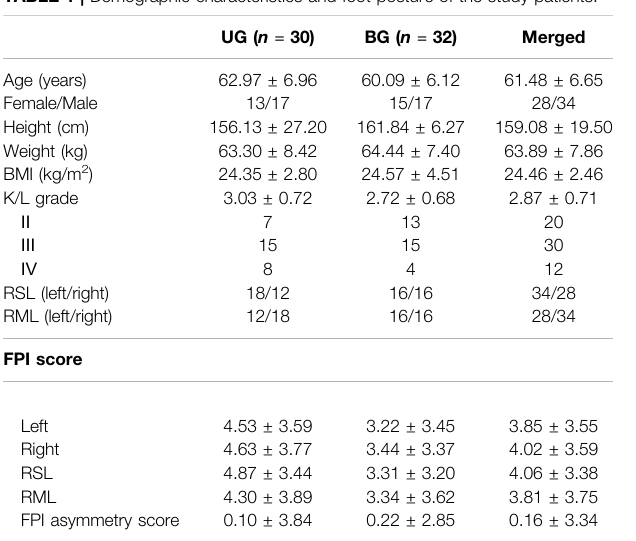
TABLE 1 | Demographic characteristics and foot posture of the study patients.